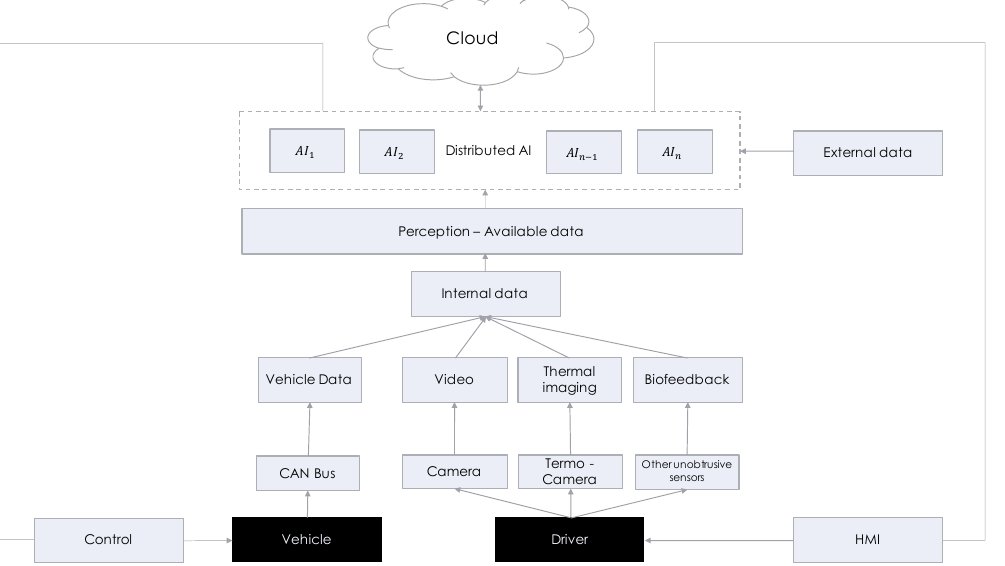
Figure 10. Schematic representation of the proposed perception